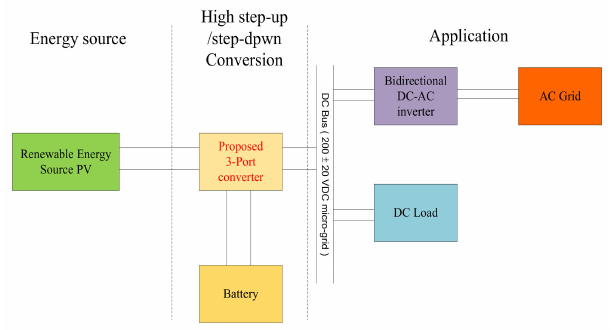
Figure 2. Block diagram of three-port bidirectional